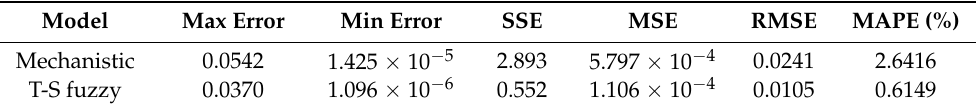
Table 4. Performance indexes of the two models under load rejection condition.